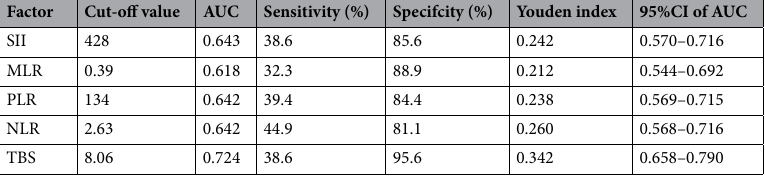
Table 2. The cut-of value and area under the curve of the inflammation index and TBS. AUC area under curve, CI confidence interval, MLR monocyte to lymphocyte ratio, PLR platelet-to-lymphocyte ratio, SII